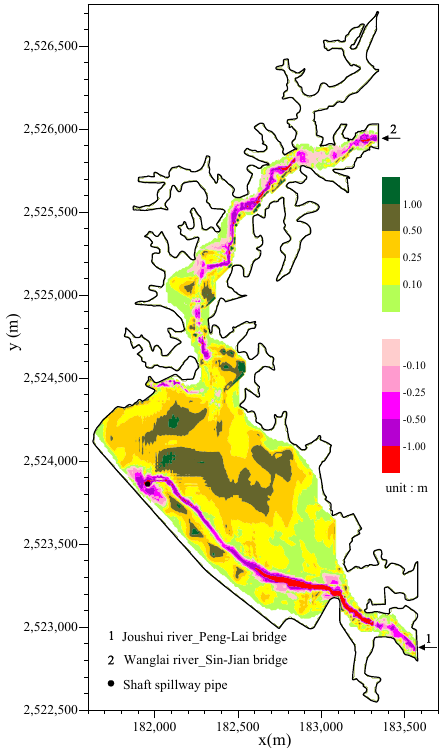
Figure 12. Bed evolution in the reservoir during a 100-year return period, t = 120 h.